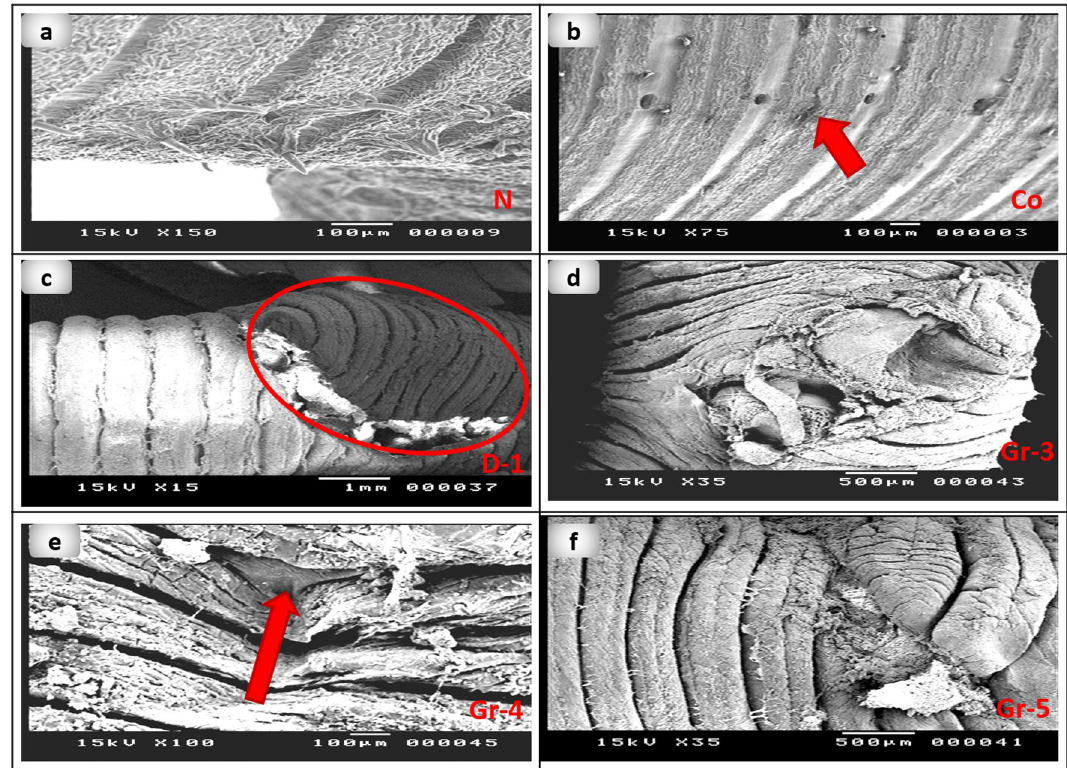
Figure 7. Scanning electron photomicrograph of the anterior part of earthworms ( Lumbricus castaneus ) after induction of surgical wounds and examination of wound healing; ( a ) normal earthworm; ( b ) worms received Vaseline, showing fissure(raw); ( c ) worm in first day of injured showing the coelomic fluid emerged as well as the blood surrounds the wound appearance (circle), and ( d ) worms received 5 mg, ( e ) worms received 10 mg showing fissure(raw), ( f ) worms received 15